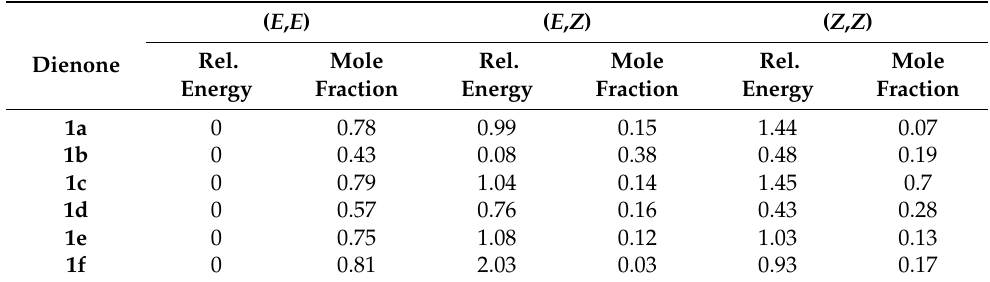
Table 5. Relative energies of ( E , E ), ( E , Z ), and ( Z , Z ) isomers in kcal · mol − 1 and mole fractions of the isomers of dienones 1a – f in the S1 state.